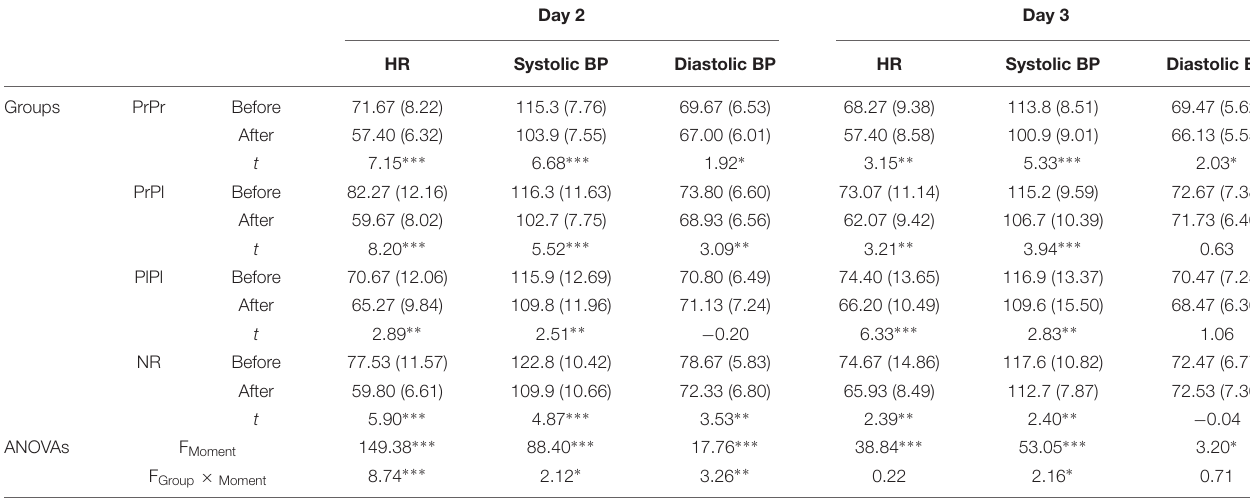
TABLE 2 | Heart rate and blood pressure before and after pill administration on Day 2 and Day